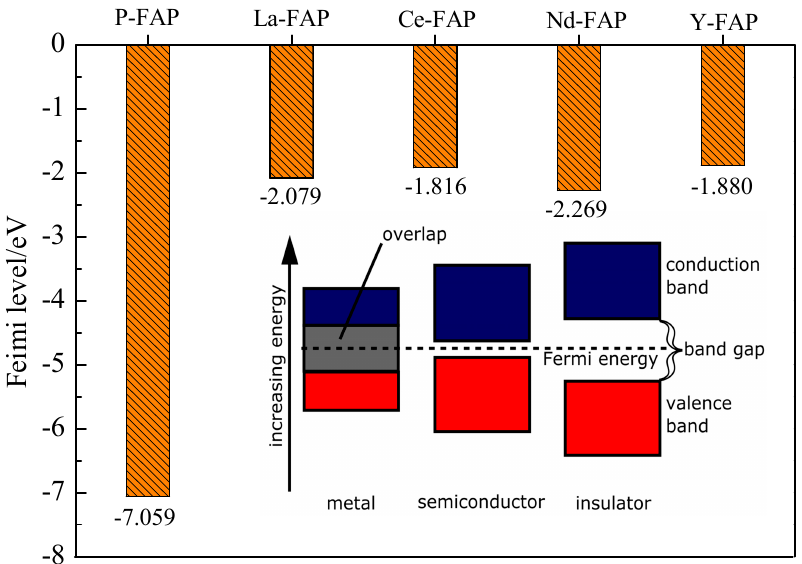
Figure 4. Fermi level of P-FAP and of REE-FAP crystals.